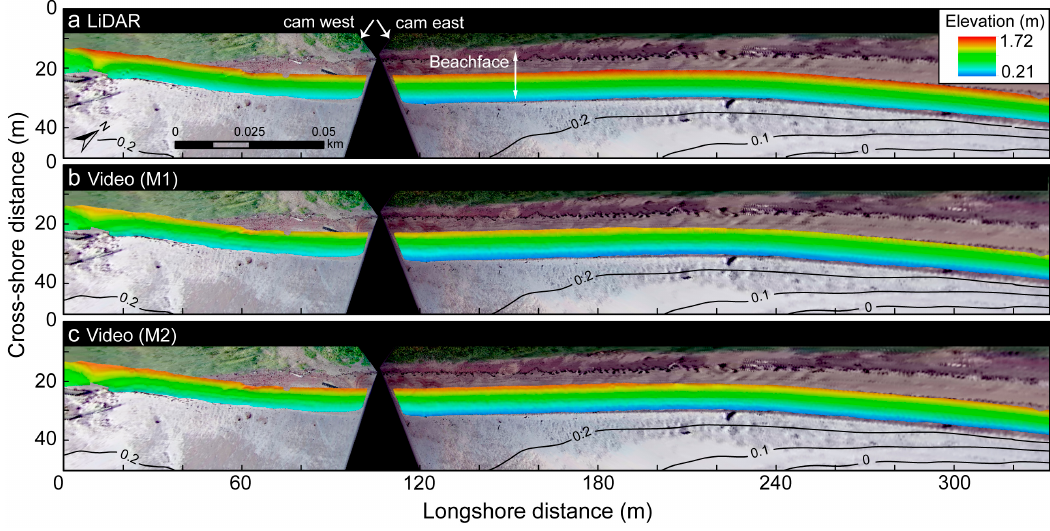
Figure 8. Beachface topography of 3 August 2016 obtained from LiDAR ( a ) and video imagery as defined with ( b ) the shoreline elevation model 1 (M1, Z mwl ) and ( c ) model 2 (M2, Z twl ).